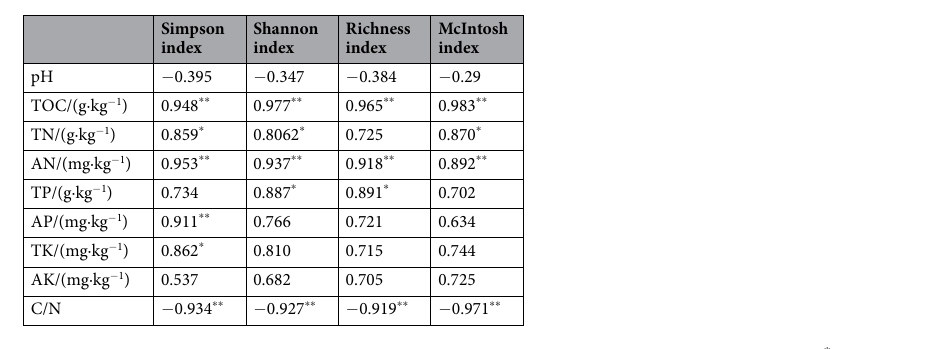
Table 4. Correlation analysis of microbial community diversity and soil properties. Note: * means P < 0. 05, significant correlation; ** means P < 0. 01, extremely significant